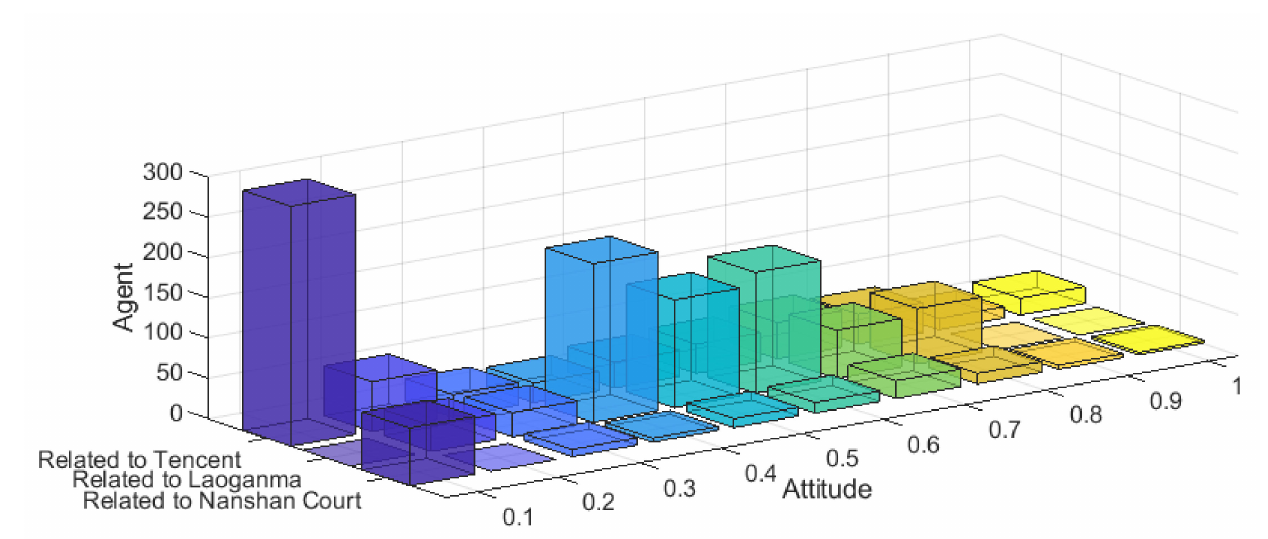
Figure 26. The distribution chart of public opinion proposed by the literature